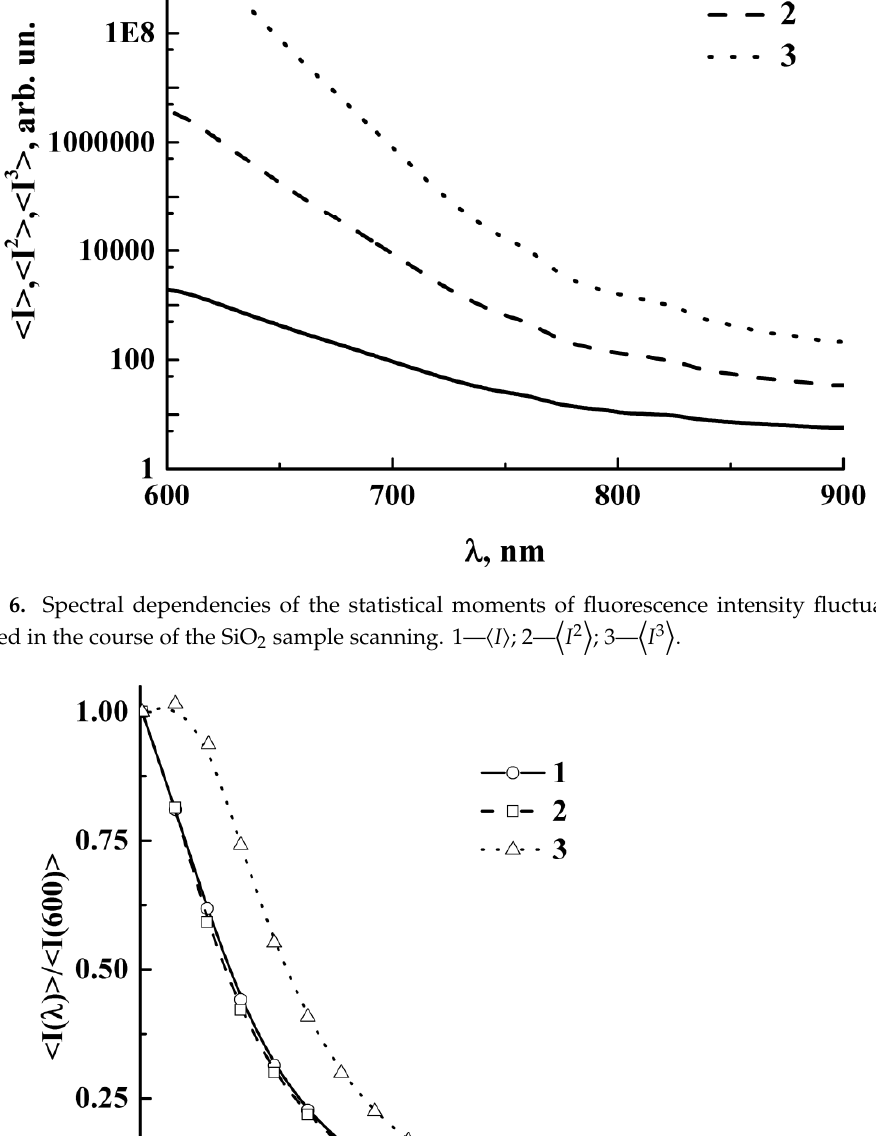
Figure 7. The normalized fluorescence spectra of the examined samples; 1—pure dye solution (“static” mode); 2—SiO 2 ‐ based system (scan mode); 3—TiO 2 ‐ based system (scan mode).